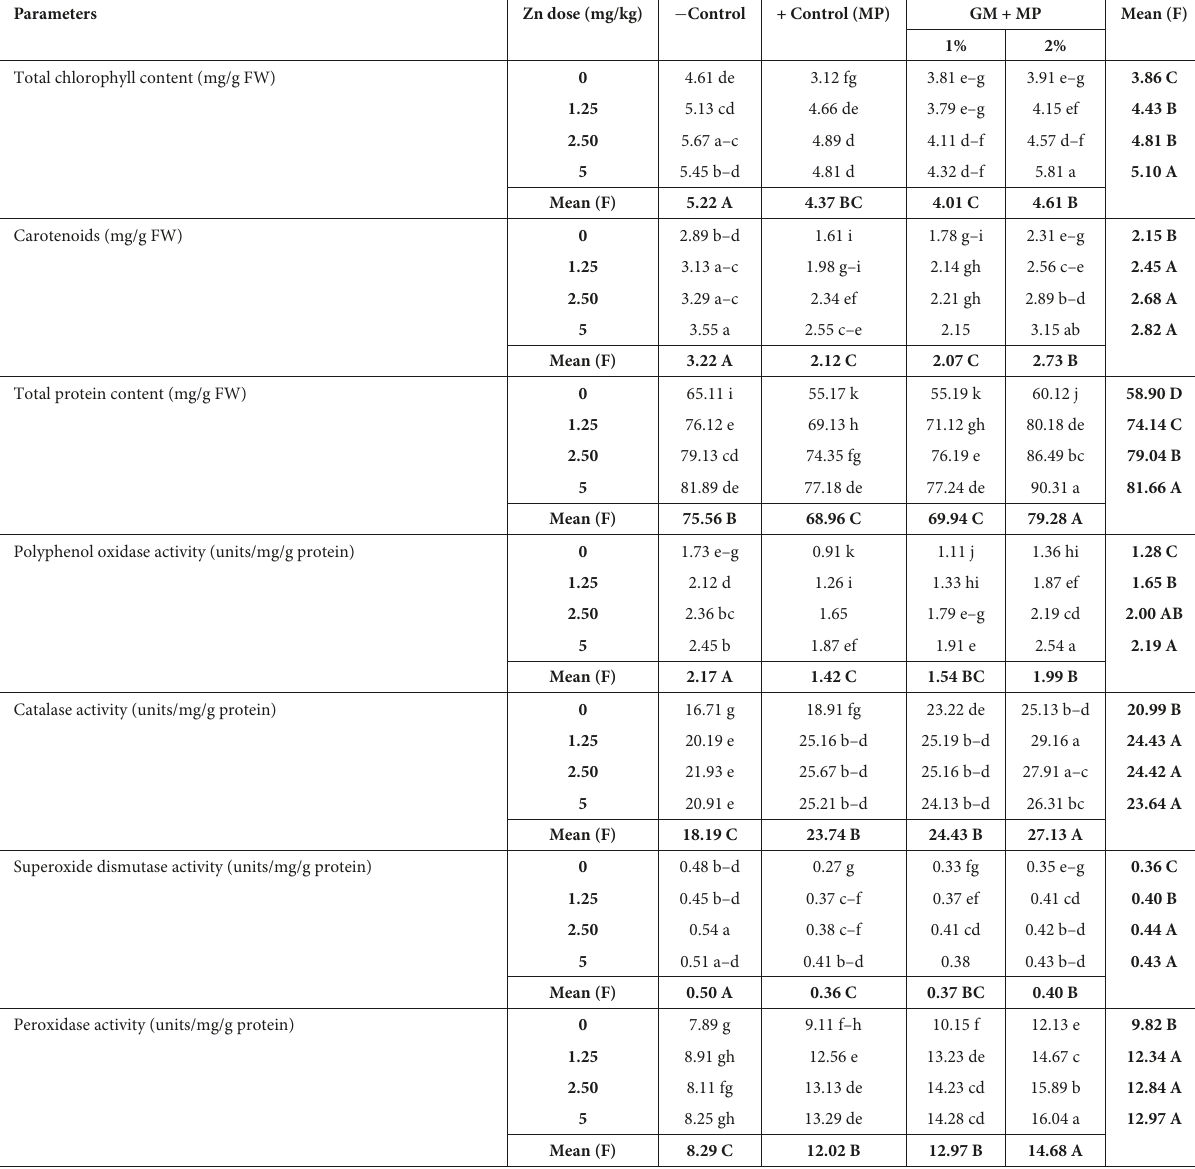
TABLE 2 Zinc (Zn) and green manure (GM) impact on physiological attributes in susceptible mungbean genotypes (MNUYT-107) of mungbean inoculated with Macrophomina phaseolina (MP). Parameters